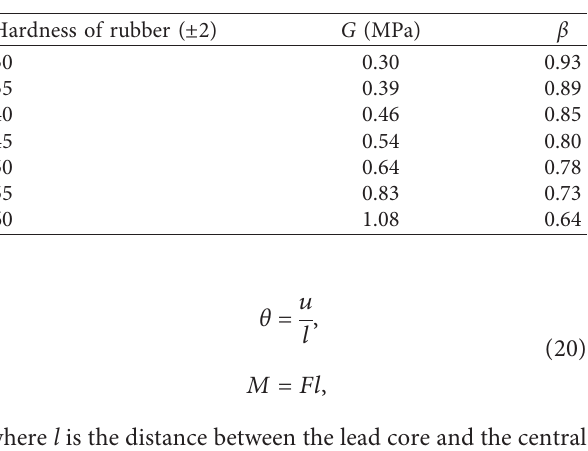
Table 1: Hardness of